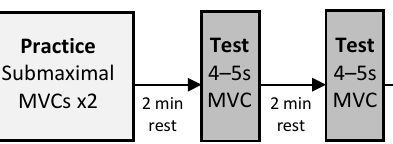
Figure 1. Session flow (replicated in second session).